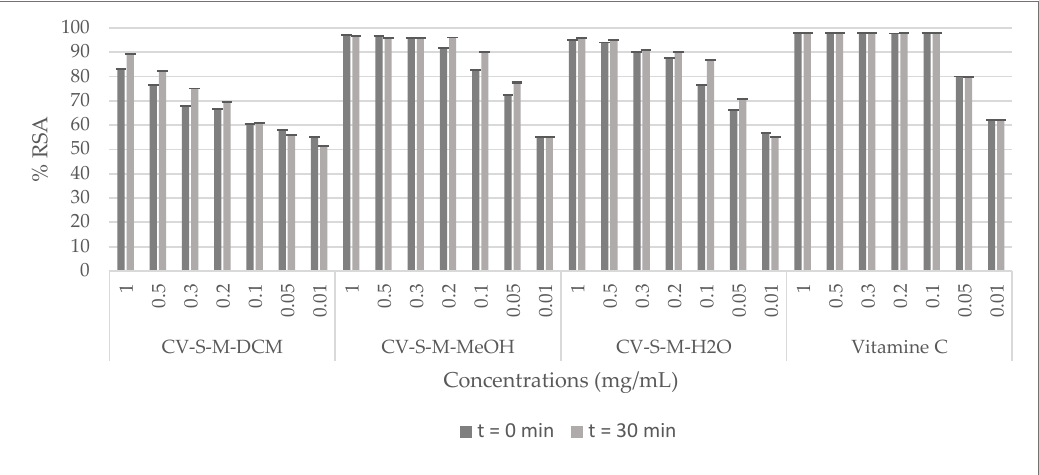
Figure 2. DPPH radical scavenging effects of C. villosa stems extracts. All values are expressed as mean of triplicate ± SD.